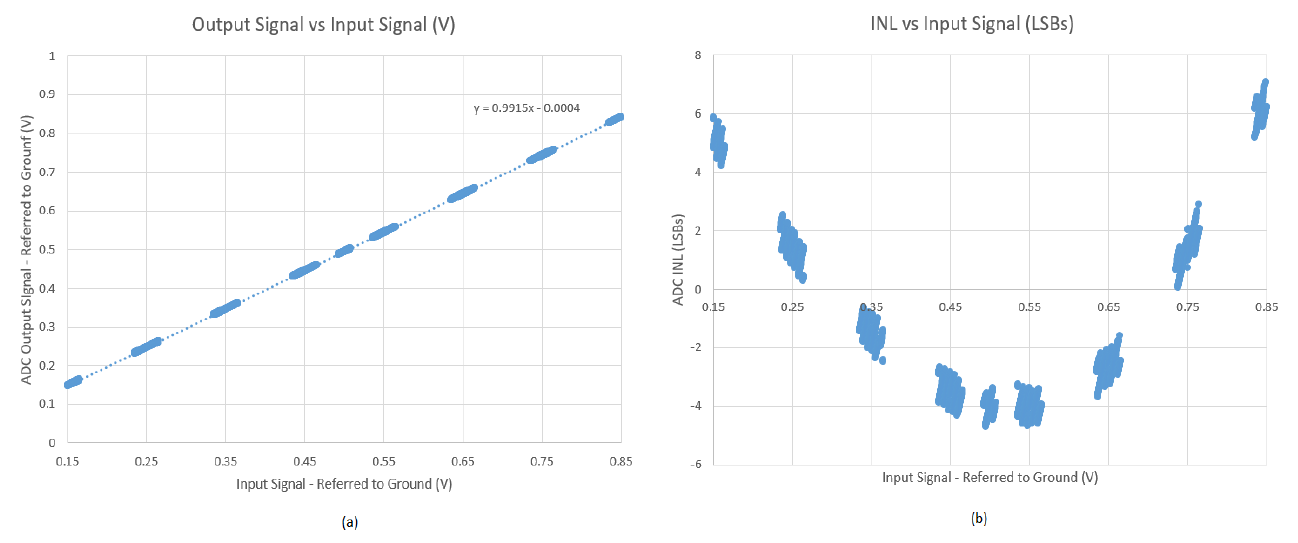
Figure 10. Extensive parametric (~3000) transistor level simulations across the ADC signal range (700 mV). ( a )—The absolute output signal (namely the equivalent analogue version of the digital output), as a function of input voltage levels; ( b )—The absolute ADC integral non-linearity (INL in units of LSBs), as a function of the input voltage level.